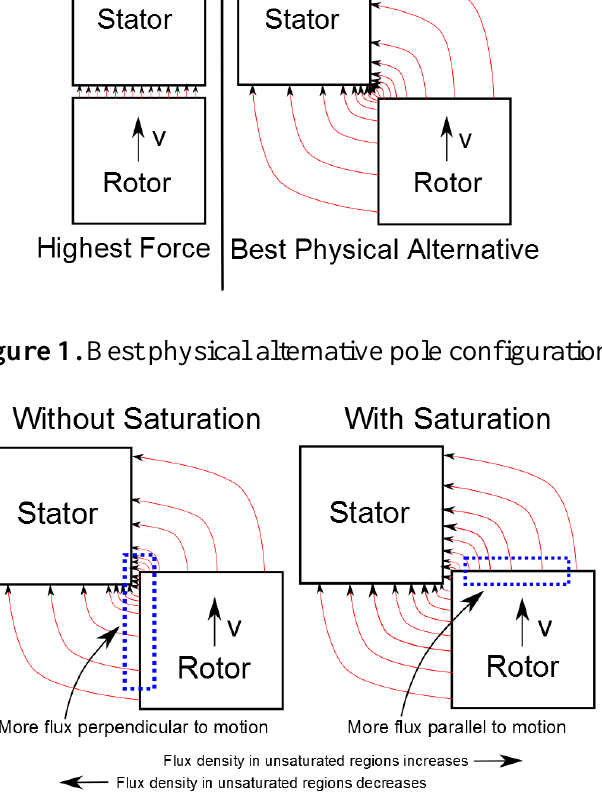
Figure 2. Effect of saturation on flux